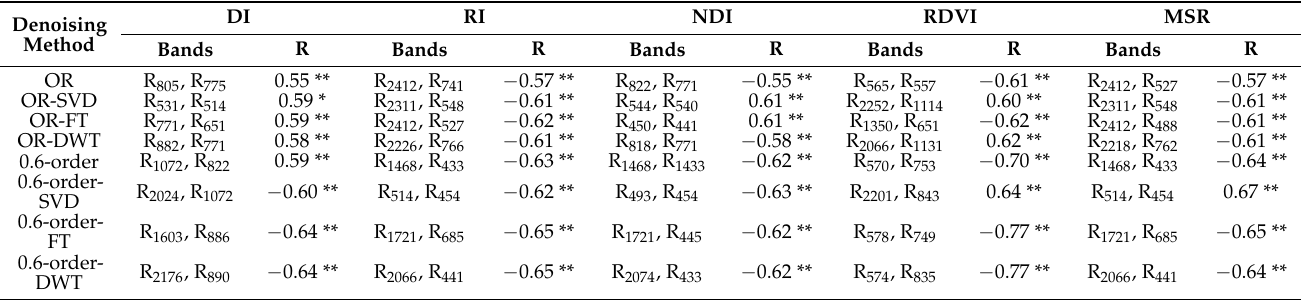
Table 3. The correlations between SOM content and the optimal DI, RI, NDI, RDVI and MSR. DI RI NDI RDVI MSR Denoising Method